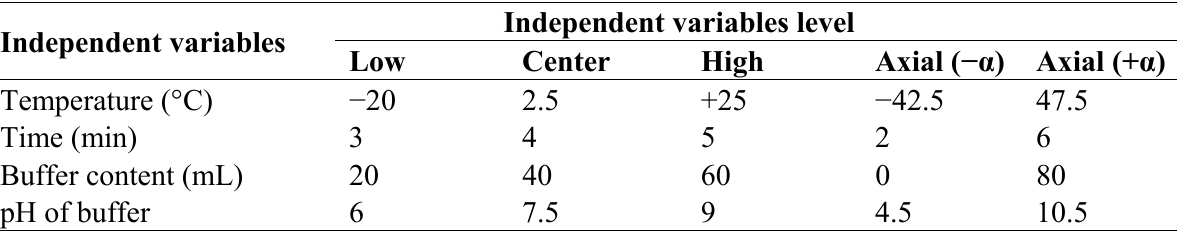
Table 5. Level of independent variables established according to central composite design